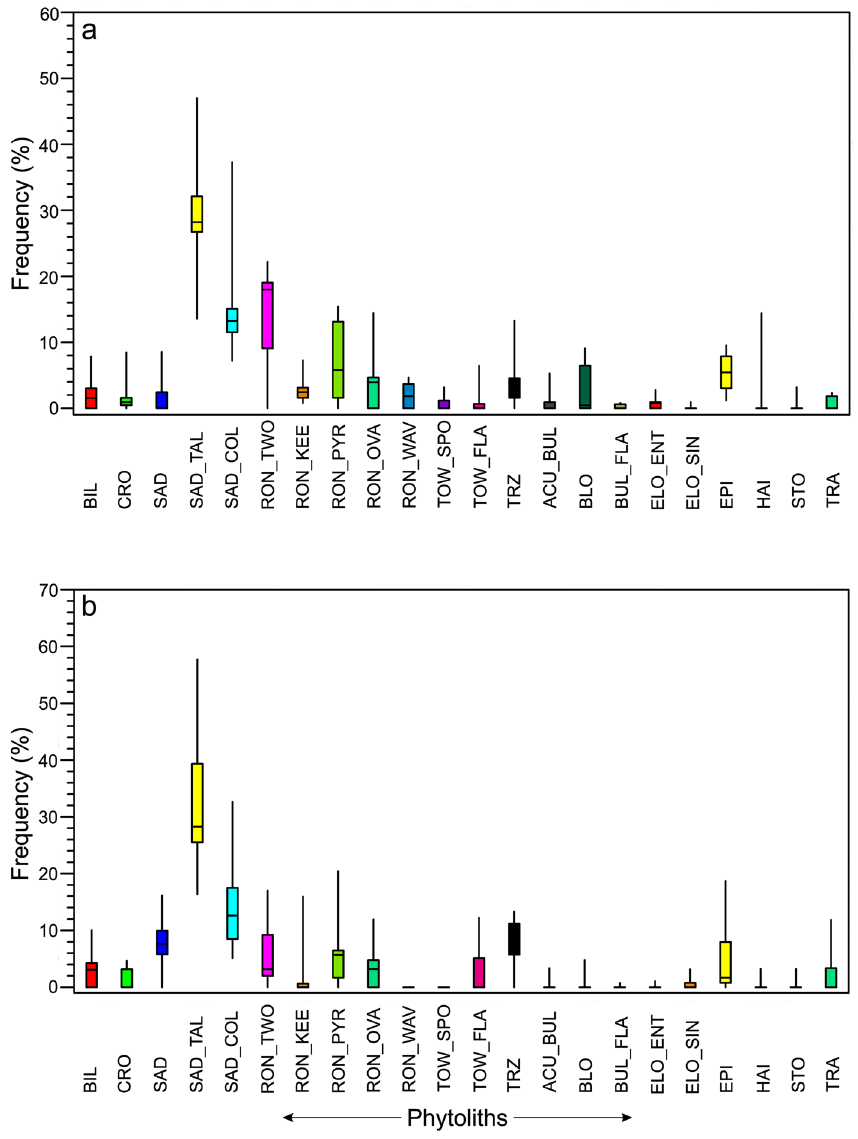
Figure 6. Box plots showing distribution of different grass phytolith types in summer ( a) and winter feces ( b)